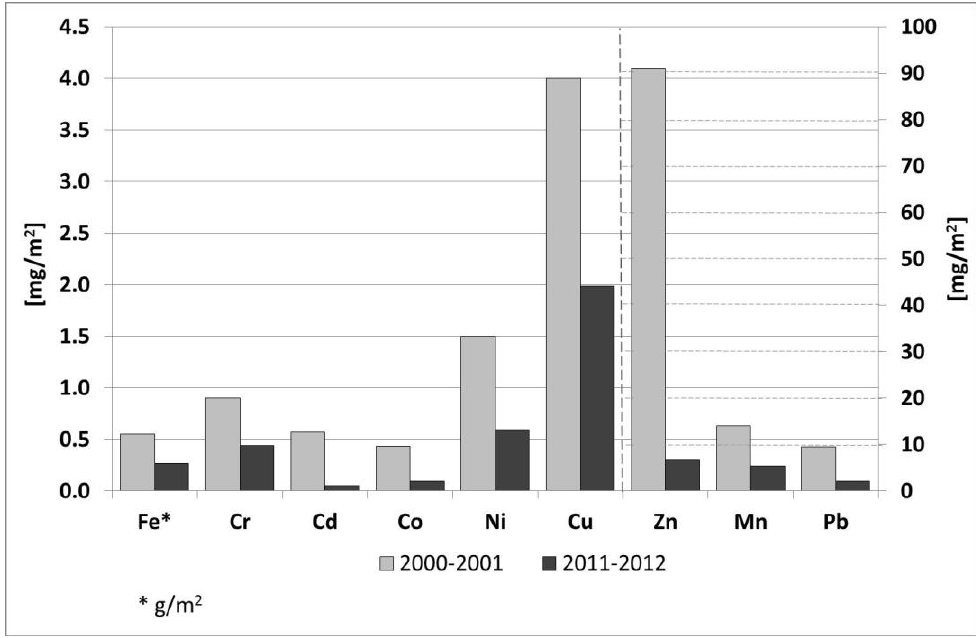
Fig. 14. Mean dry deposition values for the selected metals in Goczałkowice in 2000-2001 and 2011-2012 in [mg/m 2 ], Fe* – [g/m 2